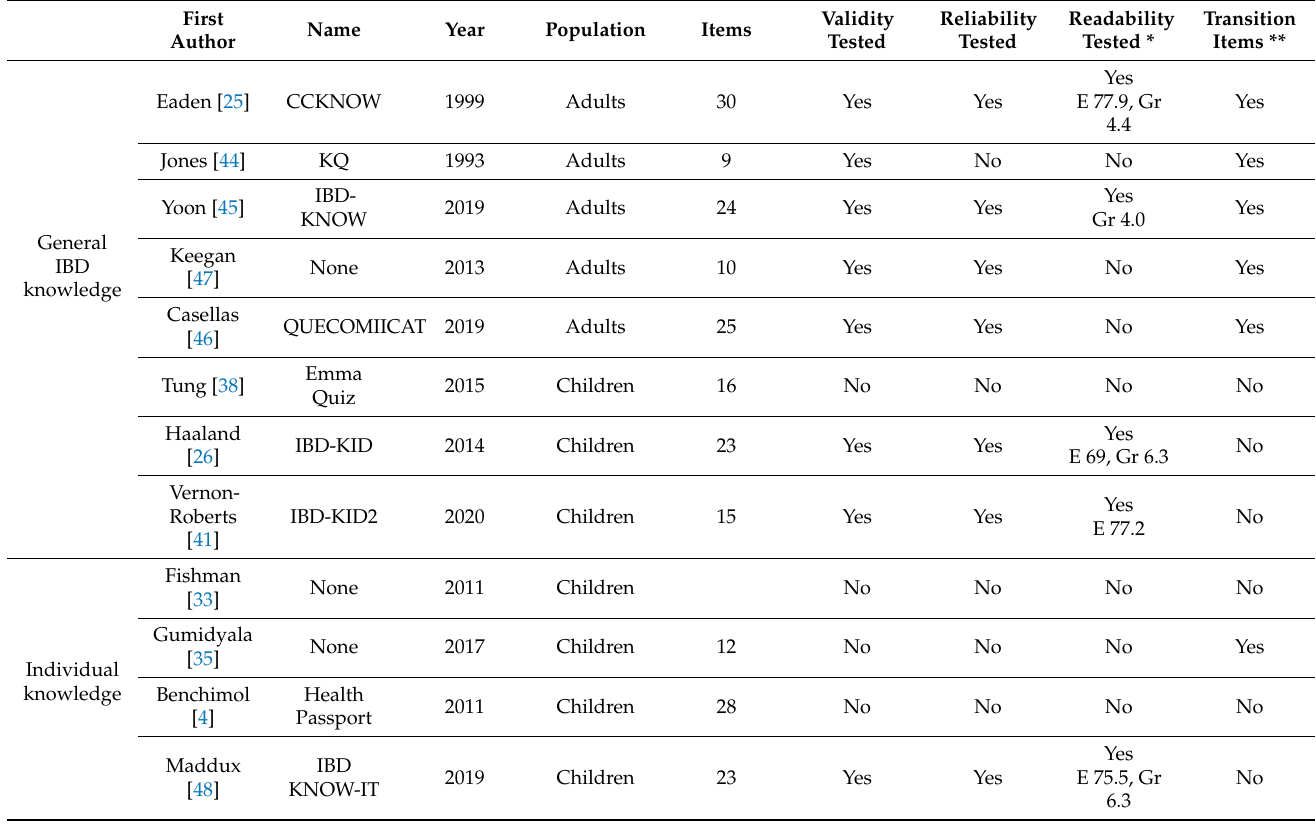
Table 1. Summary of knowledge assessment tool features to determine which is appropriate for target